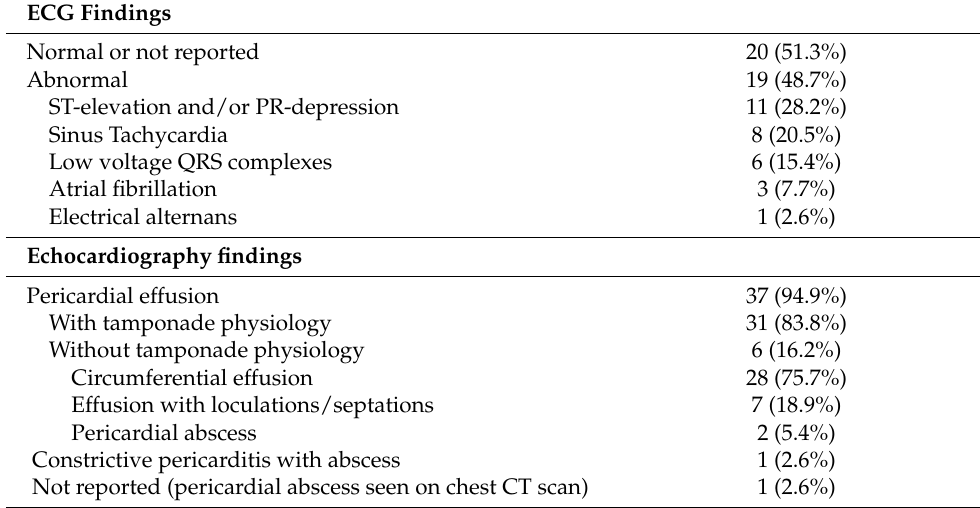
Table 2. Diagnostic findings in MRSA pericarditis